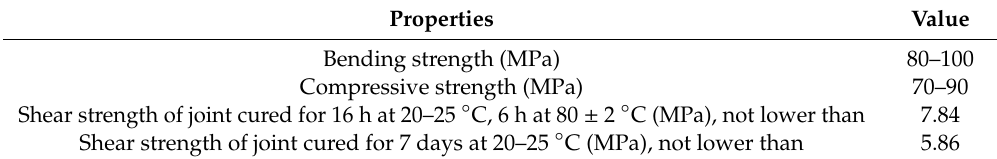
Table 1. Mechanical properties of cured Epidian 53 epoxy resin